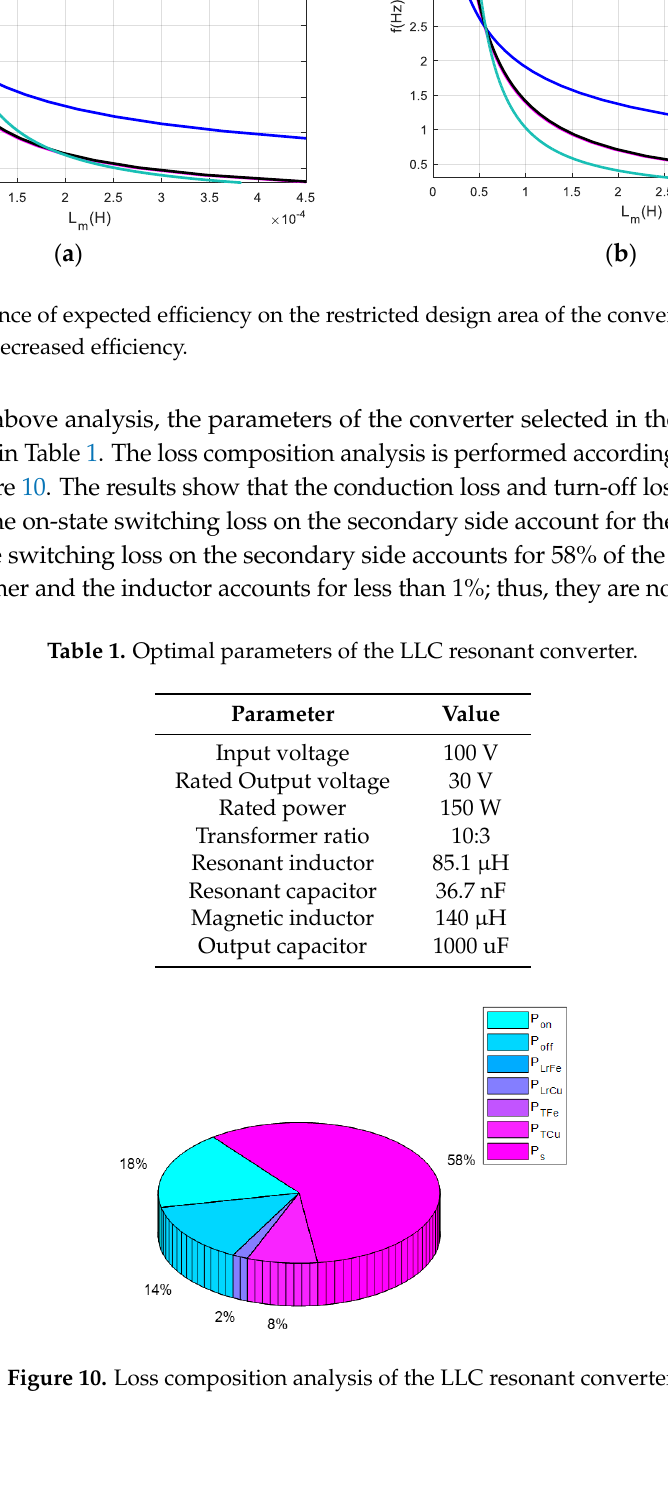
Figure 10. Loss composition analysis of the LLC resonant converter.